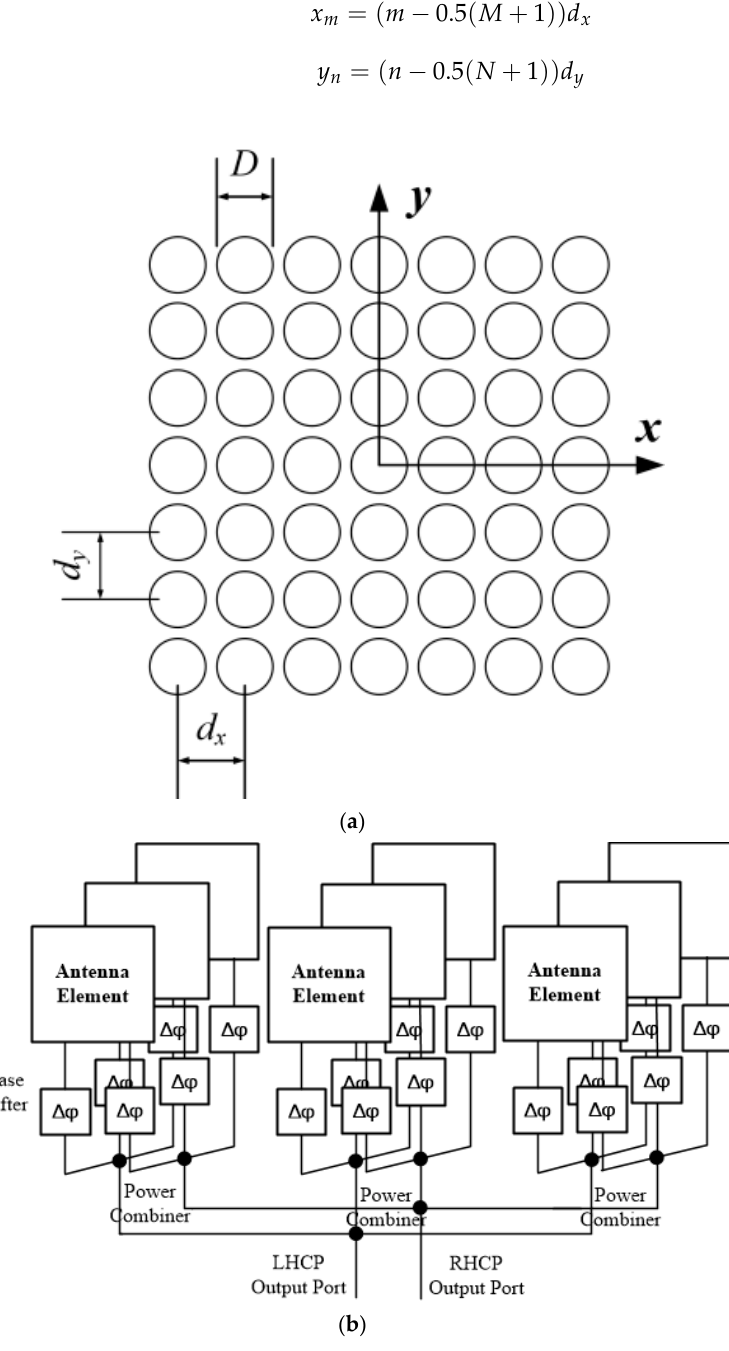
Figure 2. Structure of the NDCPPA’s ( a ) element distribution and ( b ) circuit topology. Comparing Equations (12) and (18) with the TEA method, as the gain increases, the 10log(M N) ⋅ SNR of the NDCPPA model increases by dB. For the iGNSS-R altimetry technology, the uncertainty of altimetry is mainly reflected in the uncertainty of the waveform. And the main factor affecting the altimetric precision is the randomness of the received signal caused by thermal noise and speckle noise [26].